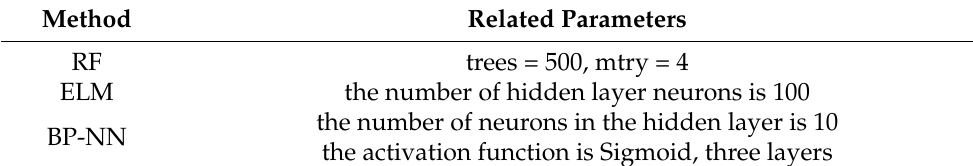
Table 3. Related parameters of the comparative test.